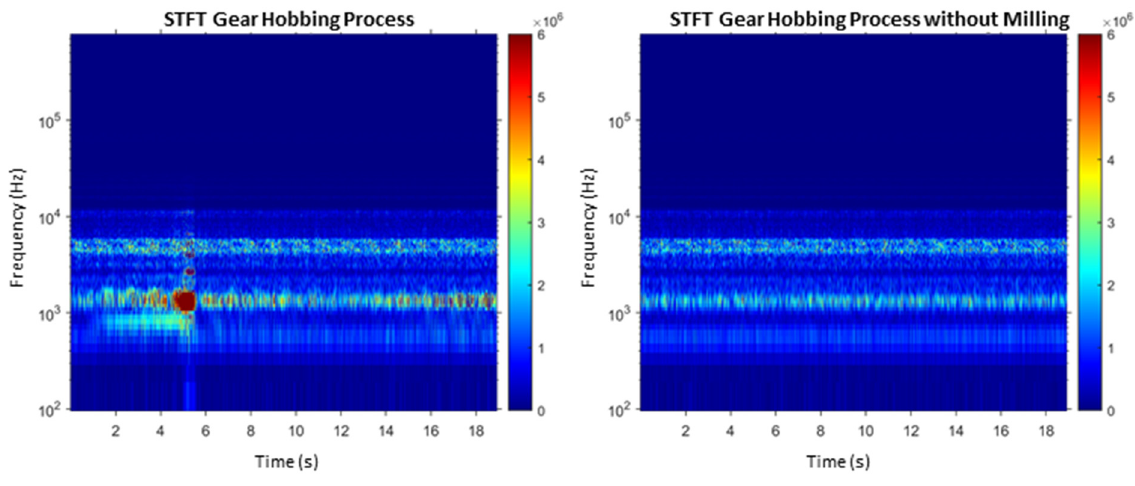
Figure 9. Comparison of the spectra of the hobbing process with cutter contact ( left ) and without contact ( right ).